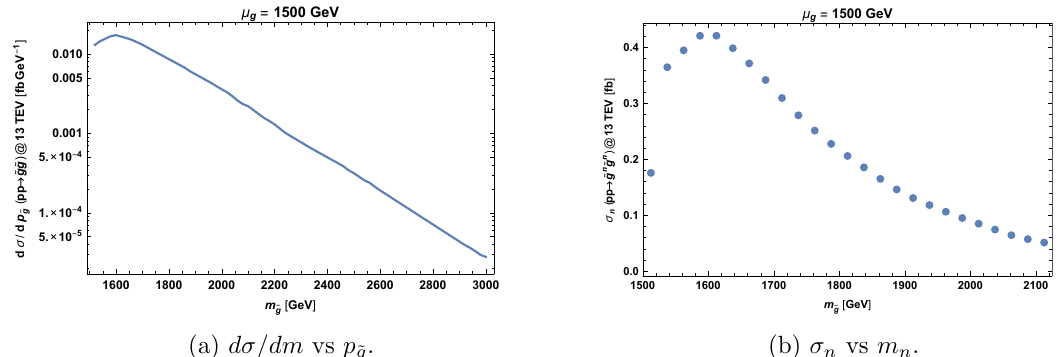
Figure 16. Di(cid:11)erential cross section of pair producing gluino continuum with (cid:22) g = 1 : 5 TeV at the LHC with 13 TeV. The right panel is a discrete estimate of the left panel, where the (cid:12)rst 20 KK modes make up & 85% of the total cross